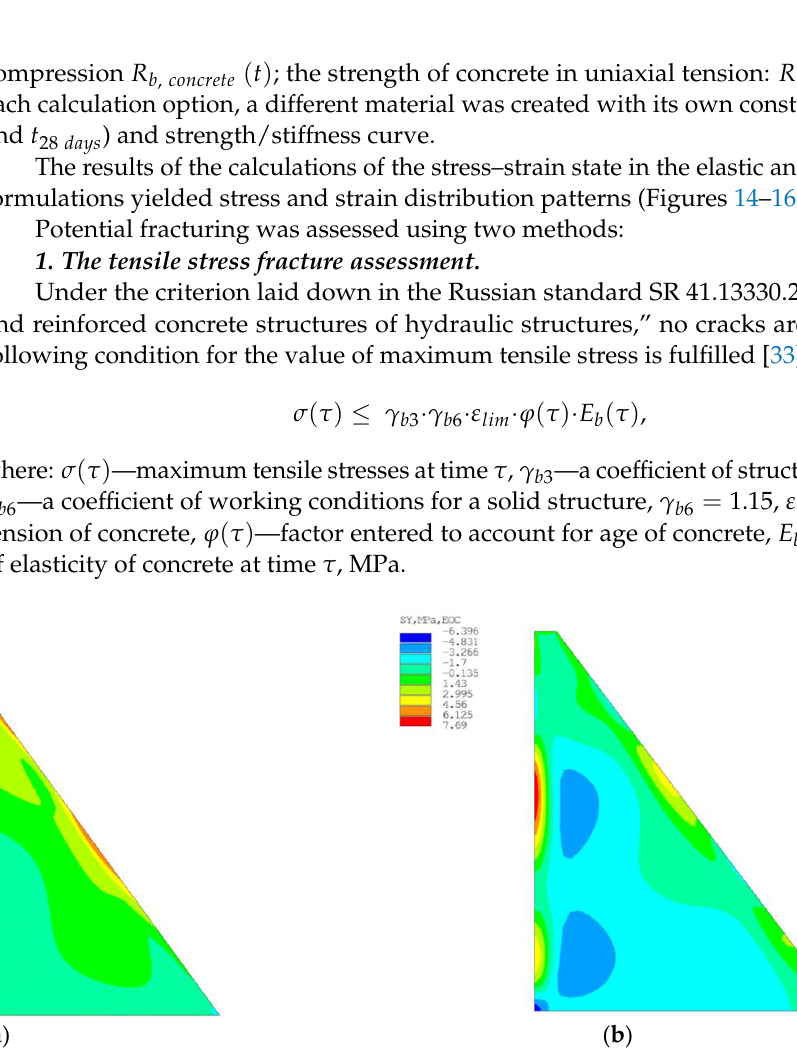
Table 2. Parameters of the calculation cases considered.